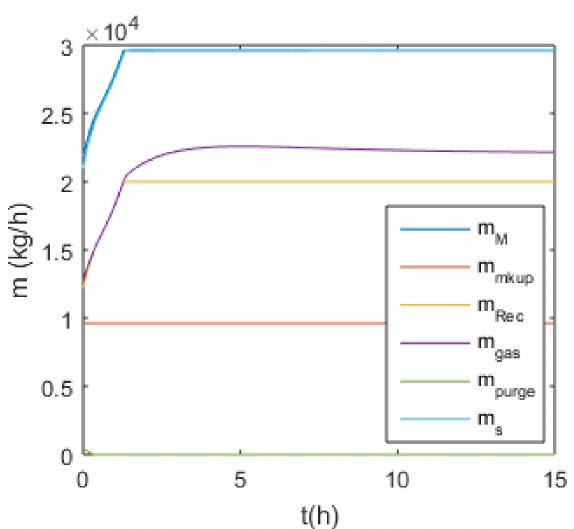
Figure 18. Mass flowrates after disturbance of +10% on the monomer make-up stream with Model